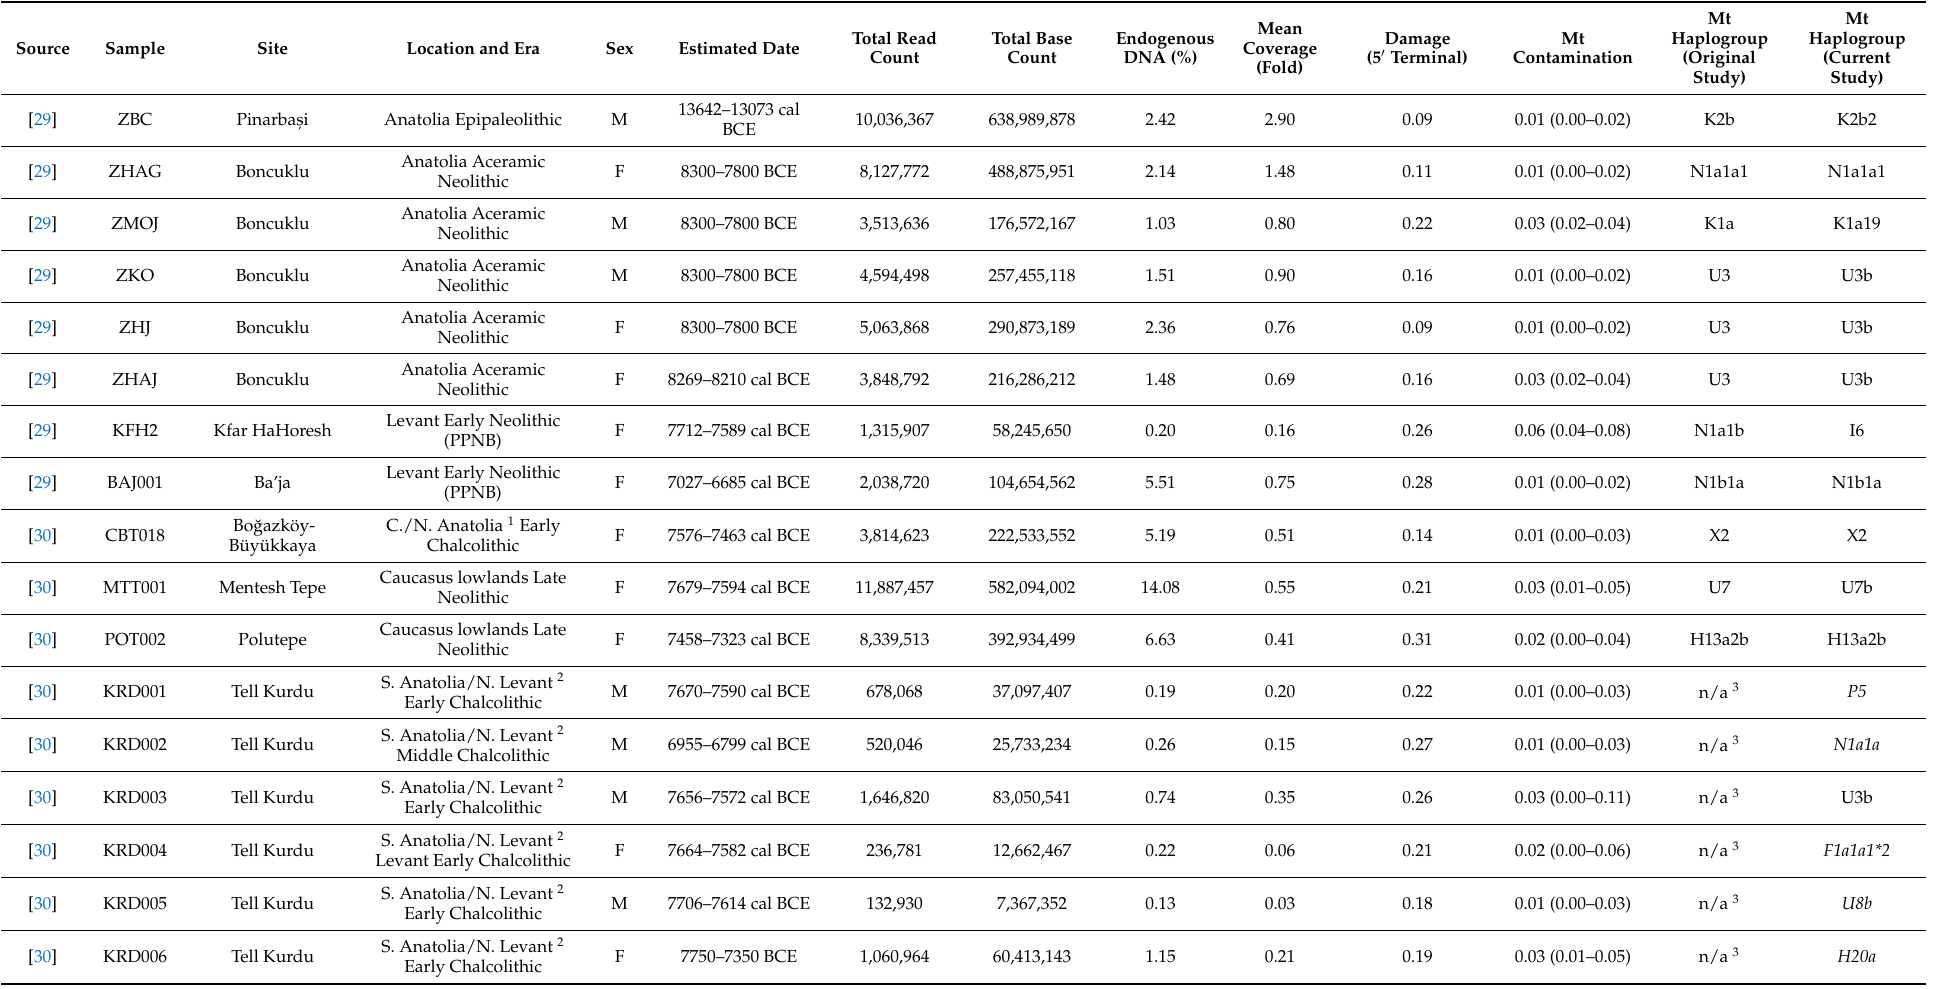
Table 1. Overview of ancient samples analyzed in the current study with details on coverage, damage, and contamination, including updated haplogroup predictions.